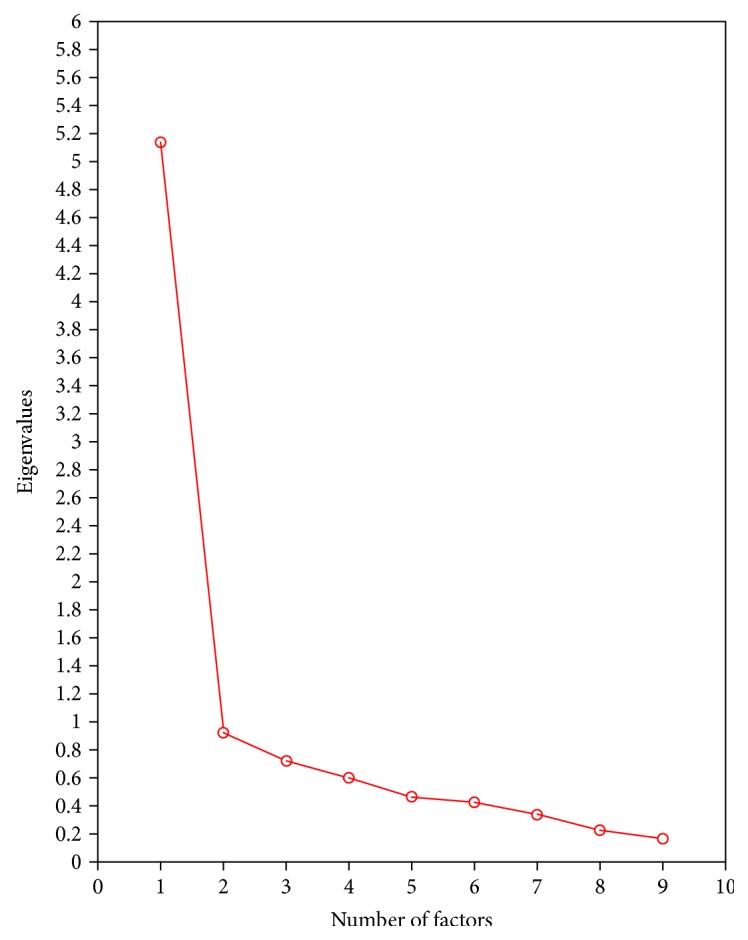
Scree Plot of the exploratory factor analysis on Dental Activities Test (n = 90).